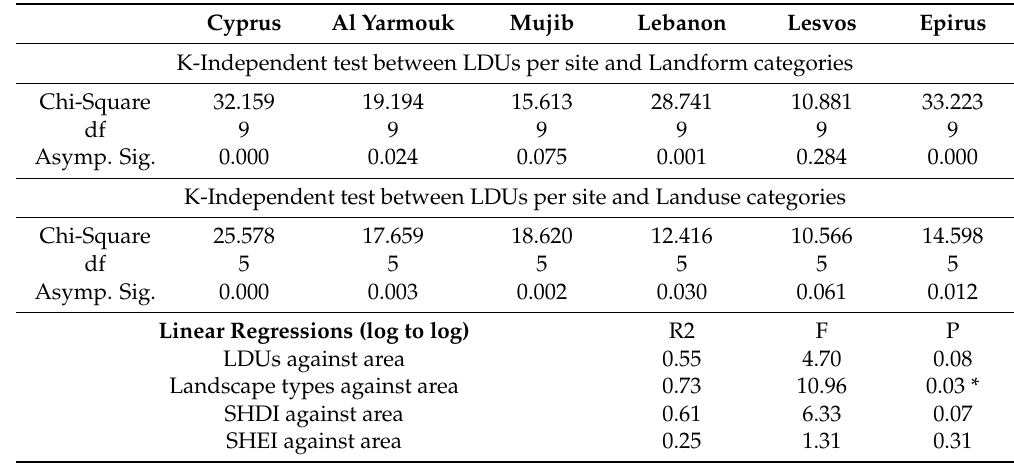
Table 5. Results for the statistical tests performed (K-Independent test between Land Description Units –LDUs, per site and Landform